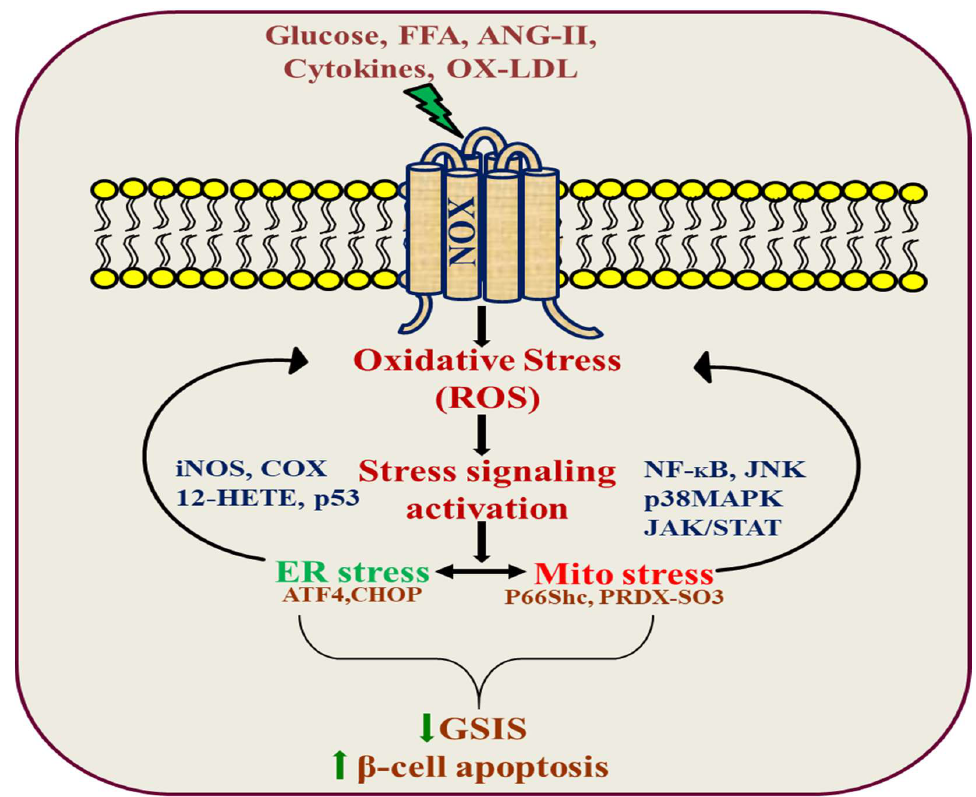
Figure 2. NADPH oxidase signal transduction in pancreatic β-cell dysfunction.